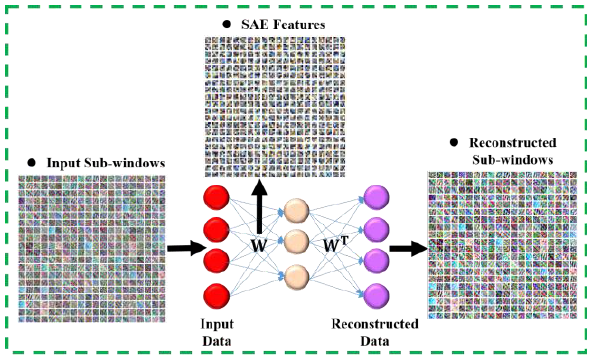
Figure 1 The network structure of the sparse auto-encoder